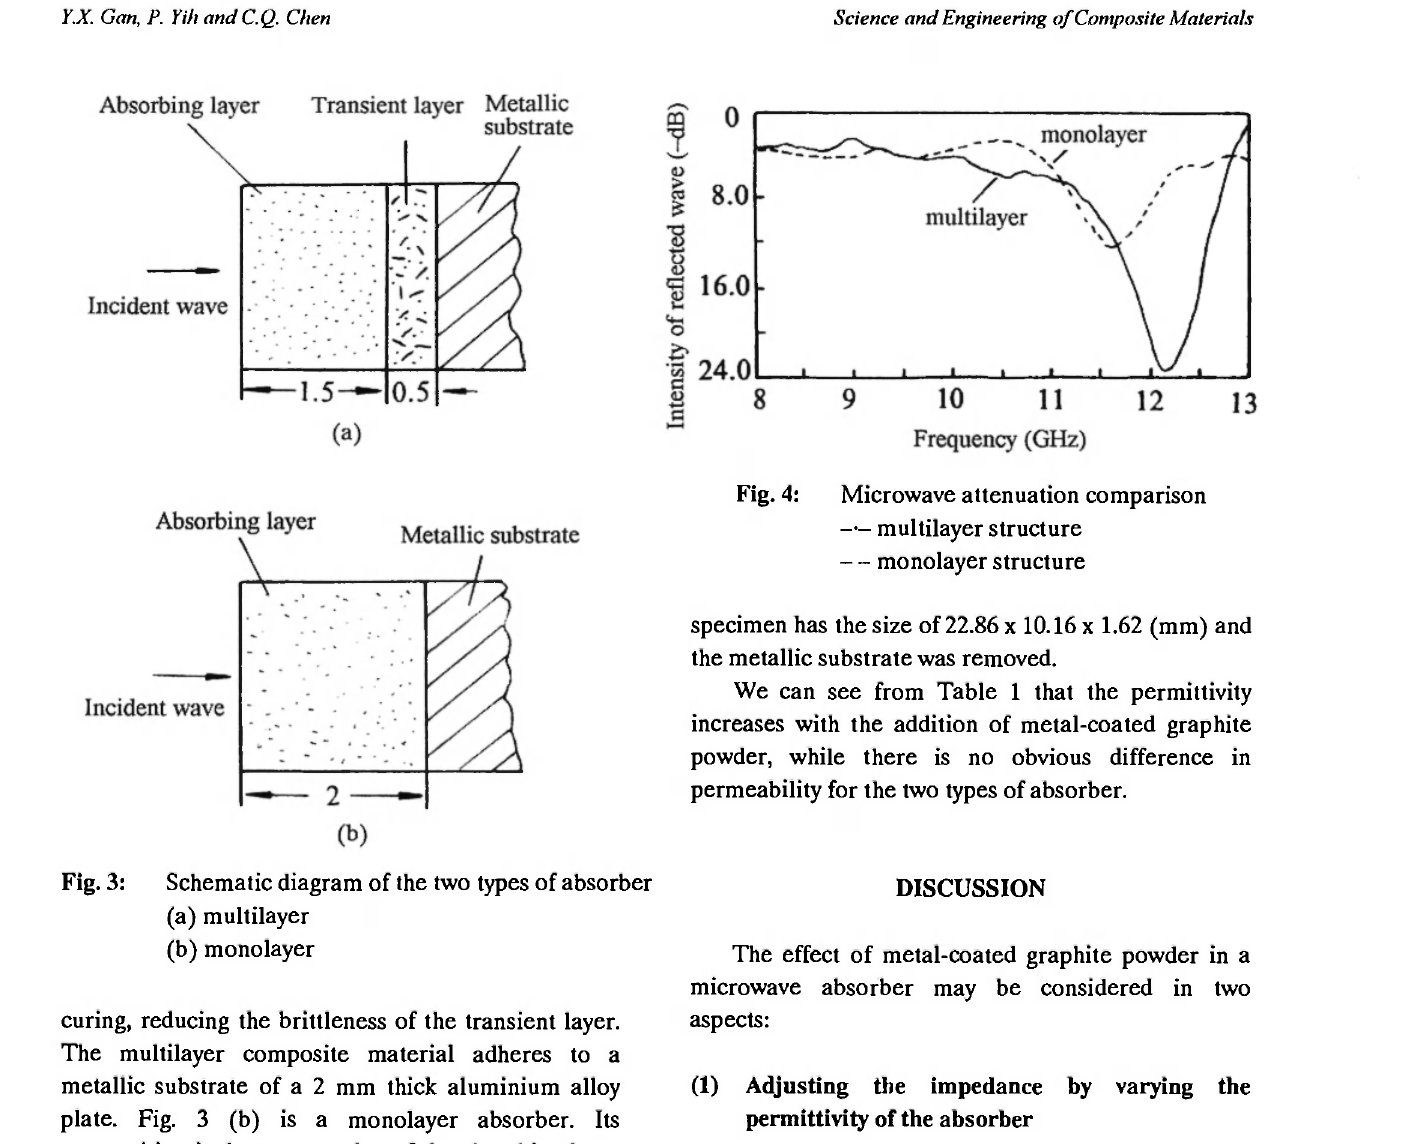
Fig. 3: Schematic diagram of the two types of absorber (a) multilayer (b) monolayer